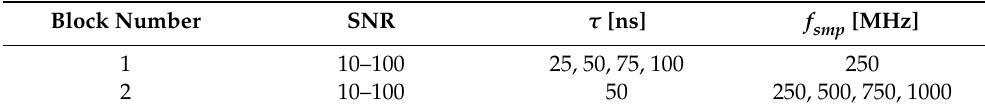
Table 1. Parameters of pulses generated during trials.